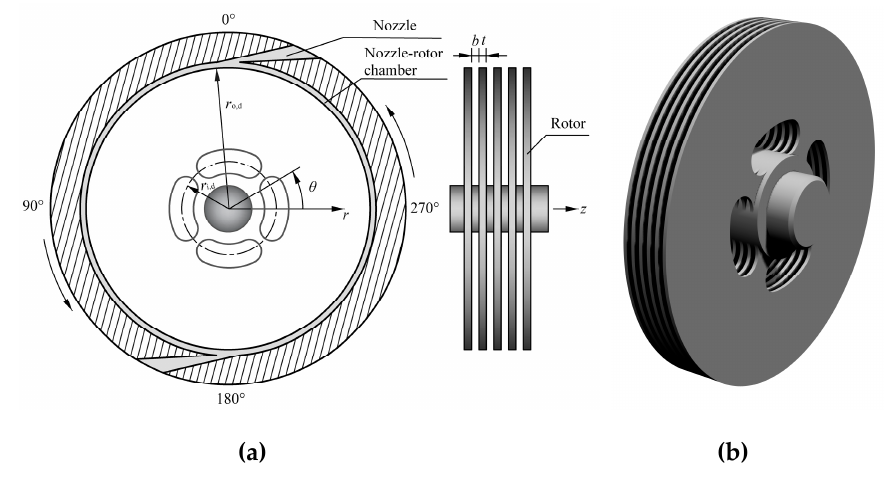
Figure 1. Tesla turbine schematic. ( a ) 2D sketch; ( b ) 3D rotor.